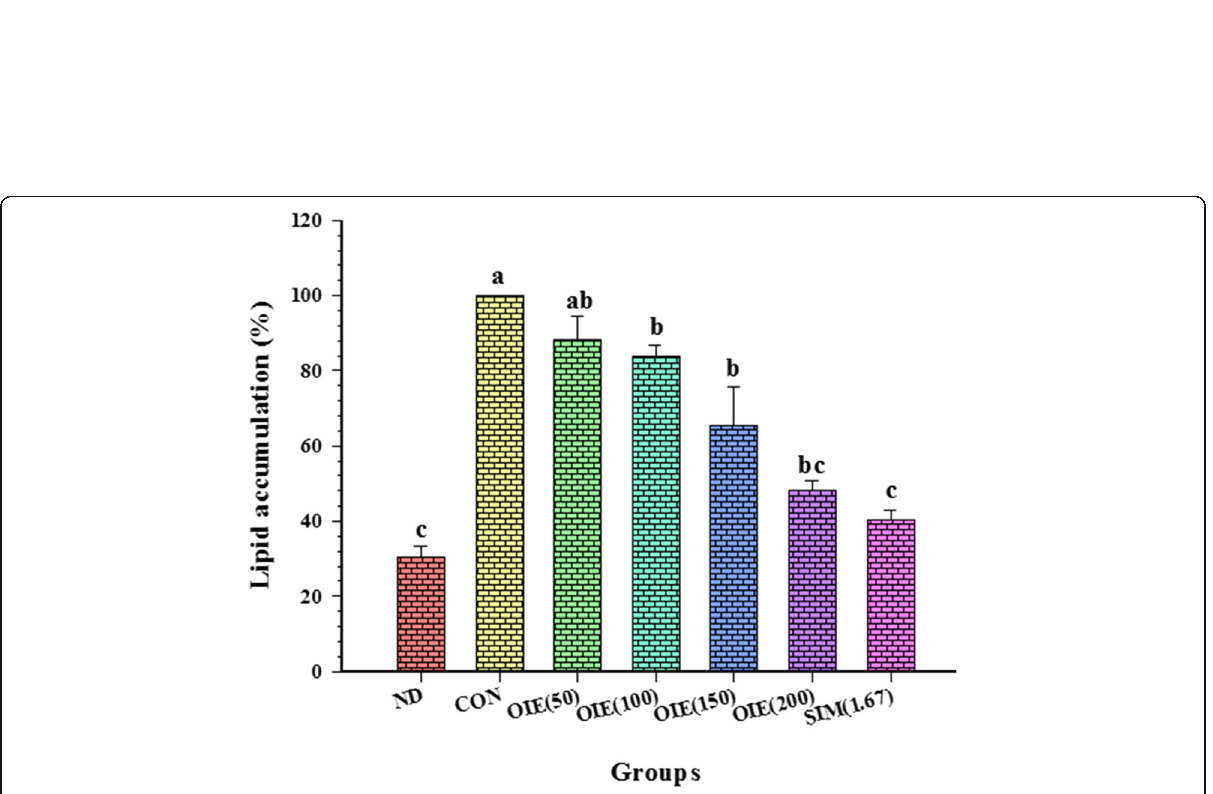
Fig. 3 The effect of Oroxylum indicum extract on the accumulation of triglycerides in 3T3-L1 differentiated cells. ND = non-differentiated cells (pre-adipocytes); CON = vehicle control; OIE(50) = Oroxylum indicum at 50 μ g/mL. SIM(1.67) = Simvastatin at 1.67 μ g/mL (a positive control). Values are Means ± SEM ( n = 3 replicates). A significant differences were observed (Tukey ’ s HSD test, p < 0.05) and are represented on the figure with letters from a to